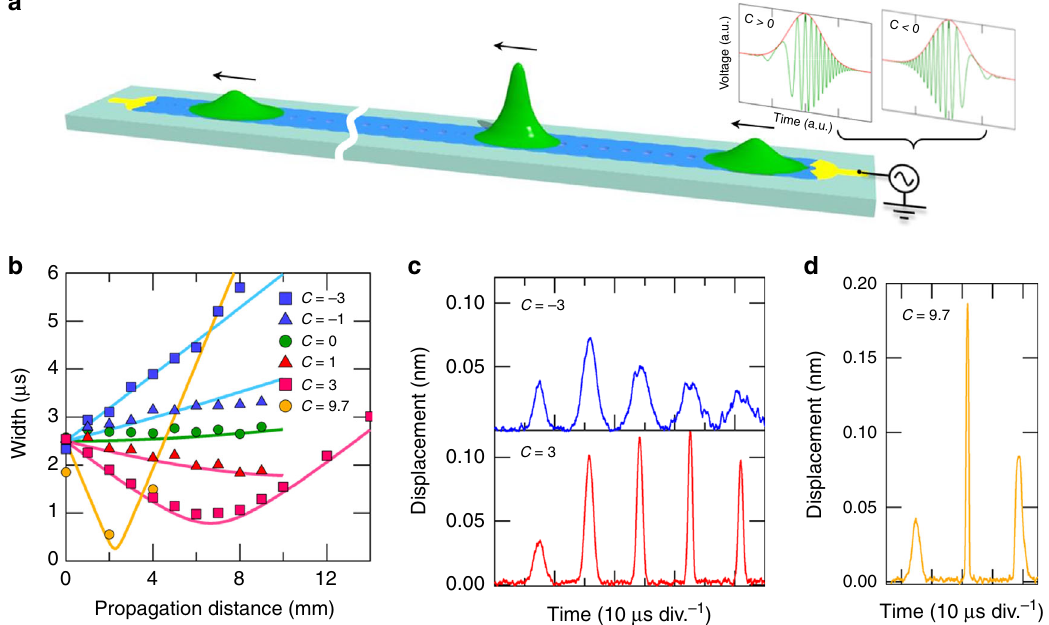
Fig. 4 Temporal focusing of ultrasonic pulses. a A schematic showing the pulse focusing caused by the GVD effect when injecting a chirped Gaussian pulse. b Temporal pulse width as a function of propagation distance when exciting a 2.5 μ s chirped pulse with a center frequency of 5.8 MHz and various chirp parameters. The GVD coef fi cient k 2 at this frequency is − 0.28 ns 2 m − 1 in Fig. 2c, indicating an anomalous dispersion regime. c , d Temporal evolution of the ultrasonic wave when exciting a chirped Gaussian pulse with a chirp parameter C = ±3 and 9.7 and measuring it at the right edge. The observed wave packets except for the fi rst are associated waves composed of the incident and re fl ected waves at the WG edge, which increase the peak amplitude nearly twofold while maintaining the pulse